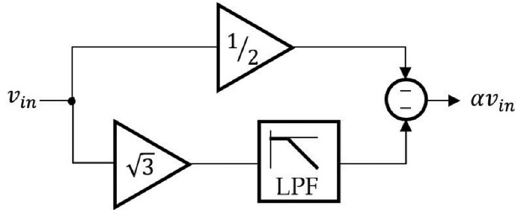
Figure 3: Time - shifting operator ( a ) implementation in the time domain [ 42 ]